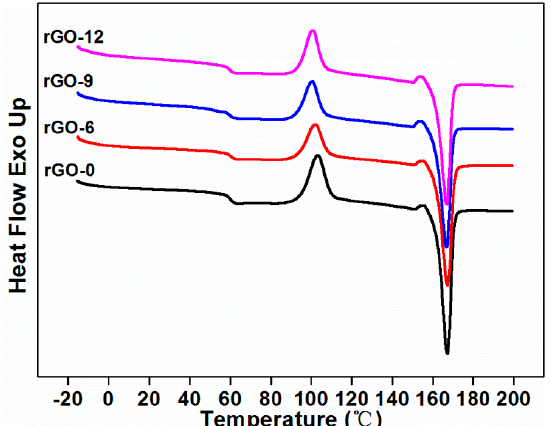
Figure 6. Second melting differential scanning calorimetry (DSC) curves of composites with varying rGO content. rGO